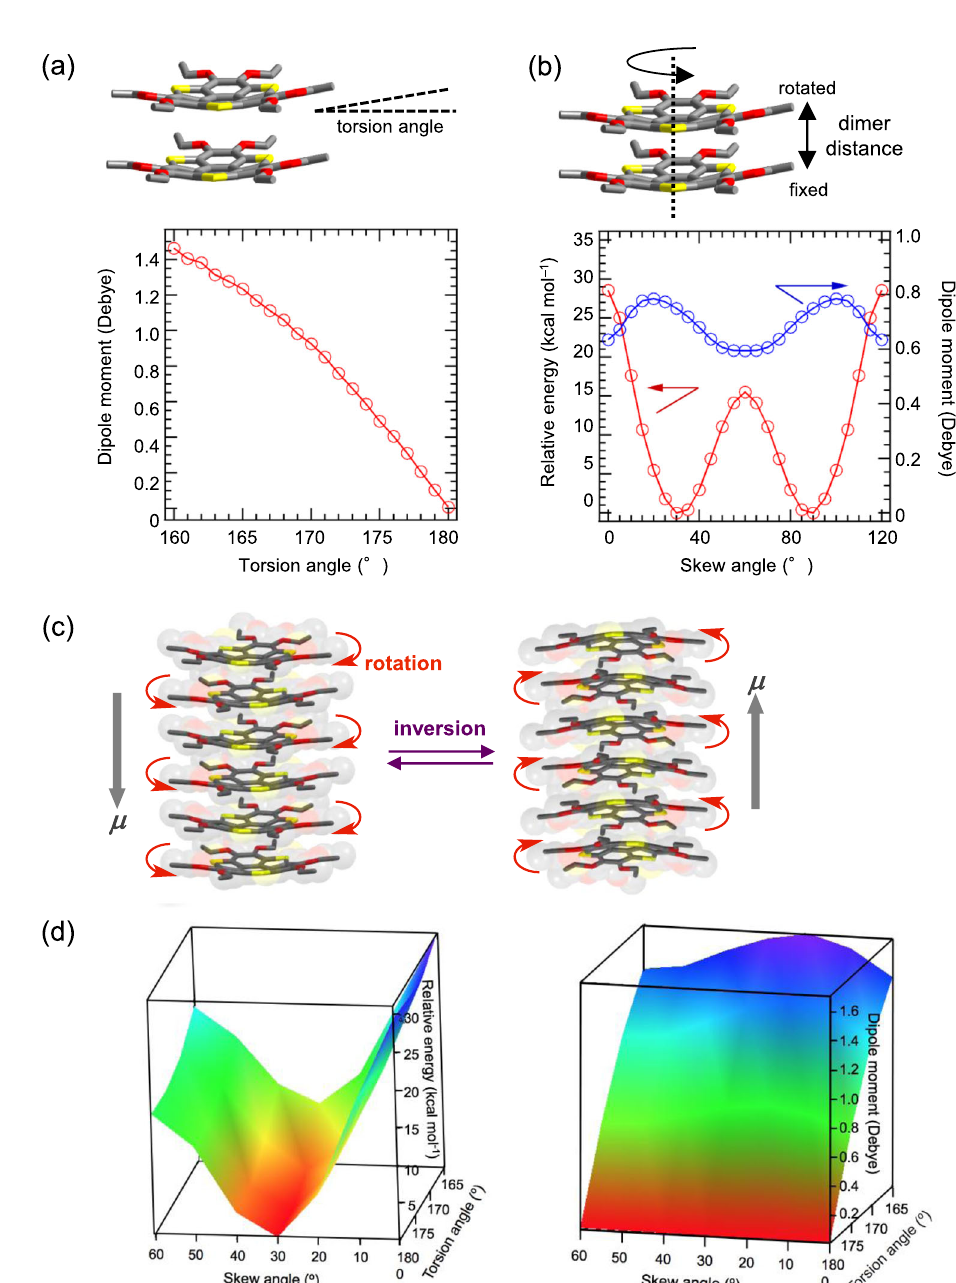
Fig. 8 Ferroelectric relaxation mechanism of C n SS derivative. a Relative energy (red in left scale) and dipole moment (blue in right scale) vs. torsion angel plots of dimeric ( C1SS ) 2 based on DFT calculations at the B3LYP 6-31 G(d) level of theory. The interdimer distance and skew angle between central benzene rings were fi xed with those of C2SS dimer in the crystal. The smallest total energy of π -planar structure with a dihedral angle of 180° was de fi ned as zero. b Relative energy (red in left scale) and dipole moment (blue in right scale) vs. skewed angel plots of dimeric ( C1SS ) 2 . The total energy of bowl- shaped structure with a skew angle of 30° and 90° was de fi ned as zero. c Schematic dipole inversion mechanism coupled with fl uctuation/inversion of bowl-shaped conformation and skew rotation. d 3D plots of relative energy (left) and dipole moment (right) against torsion angle and skew angle of dimeric ( C1SS ) 2